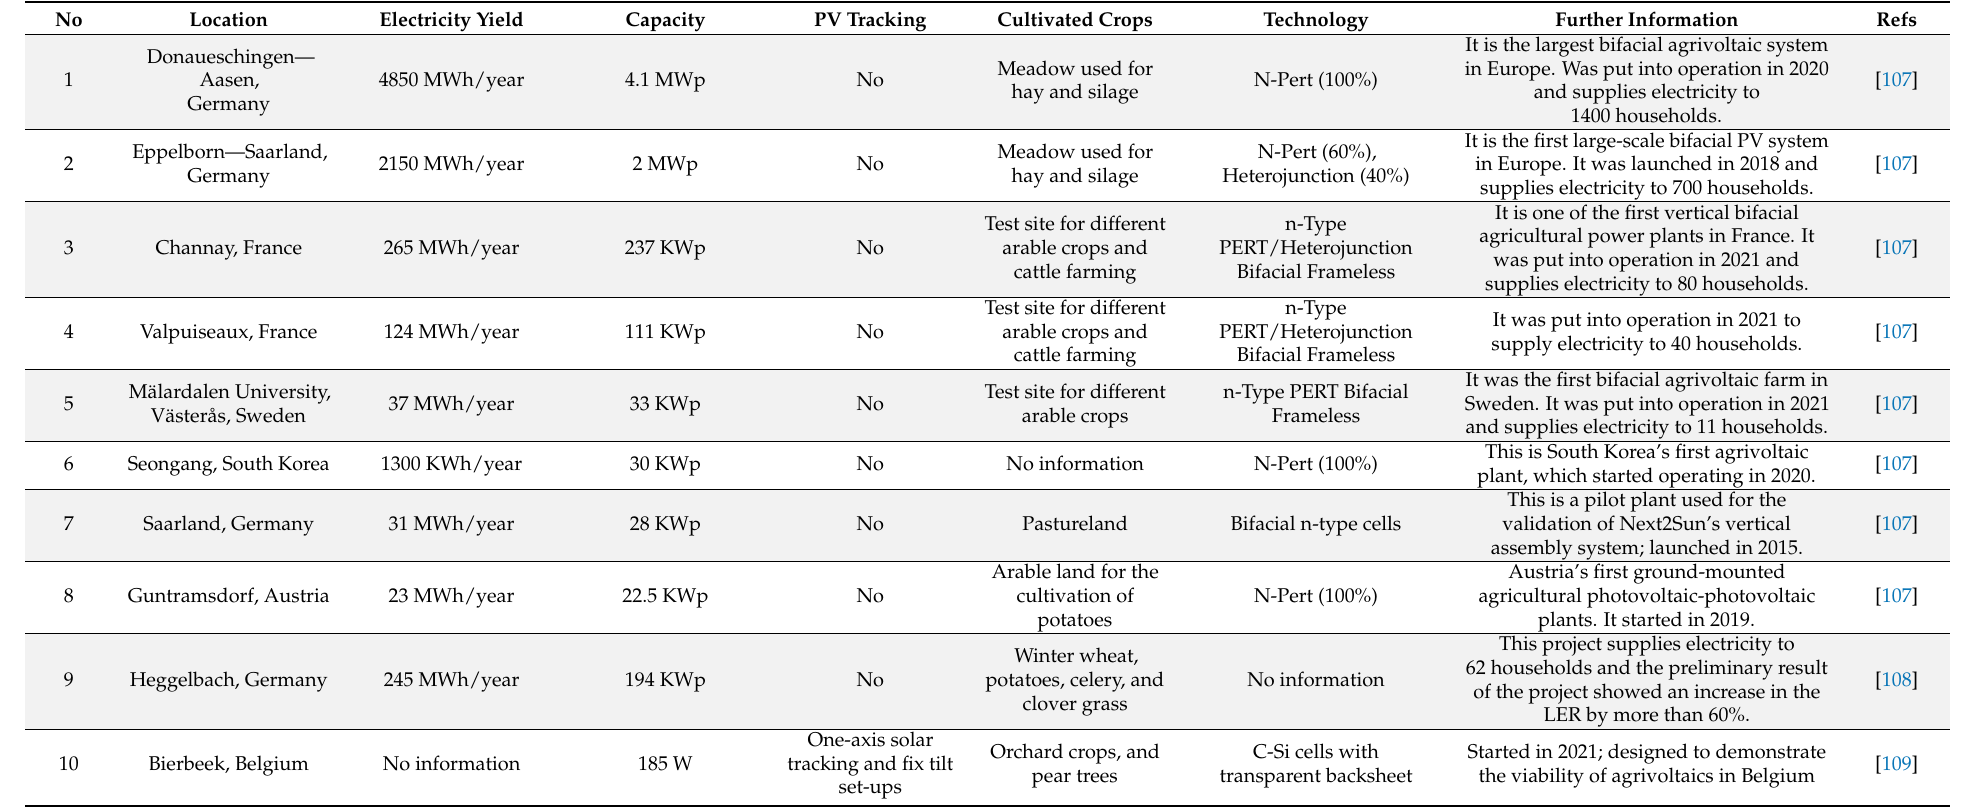
Table 2. List of operational bifacial agricultural photovoltaic